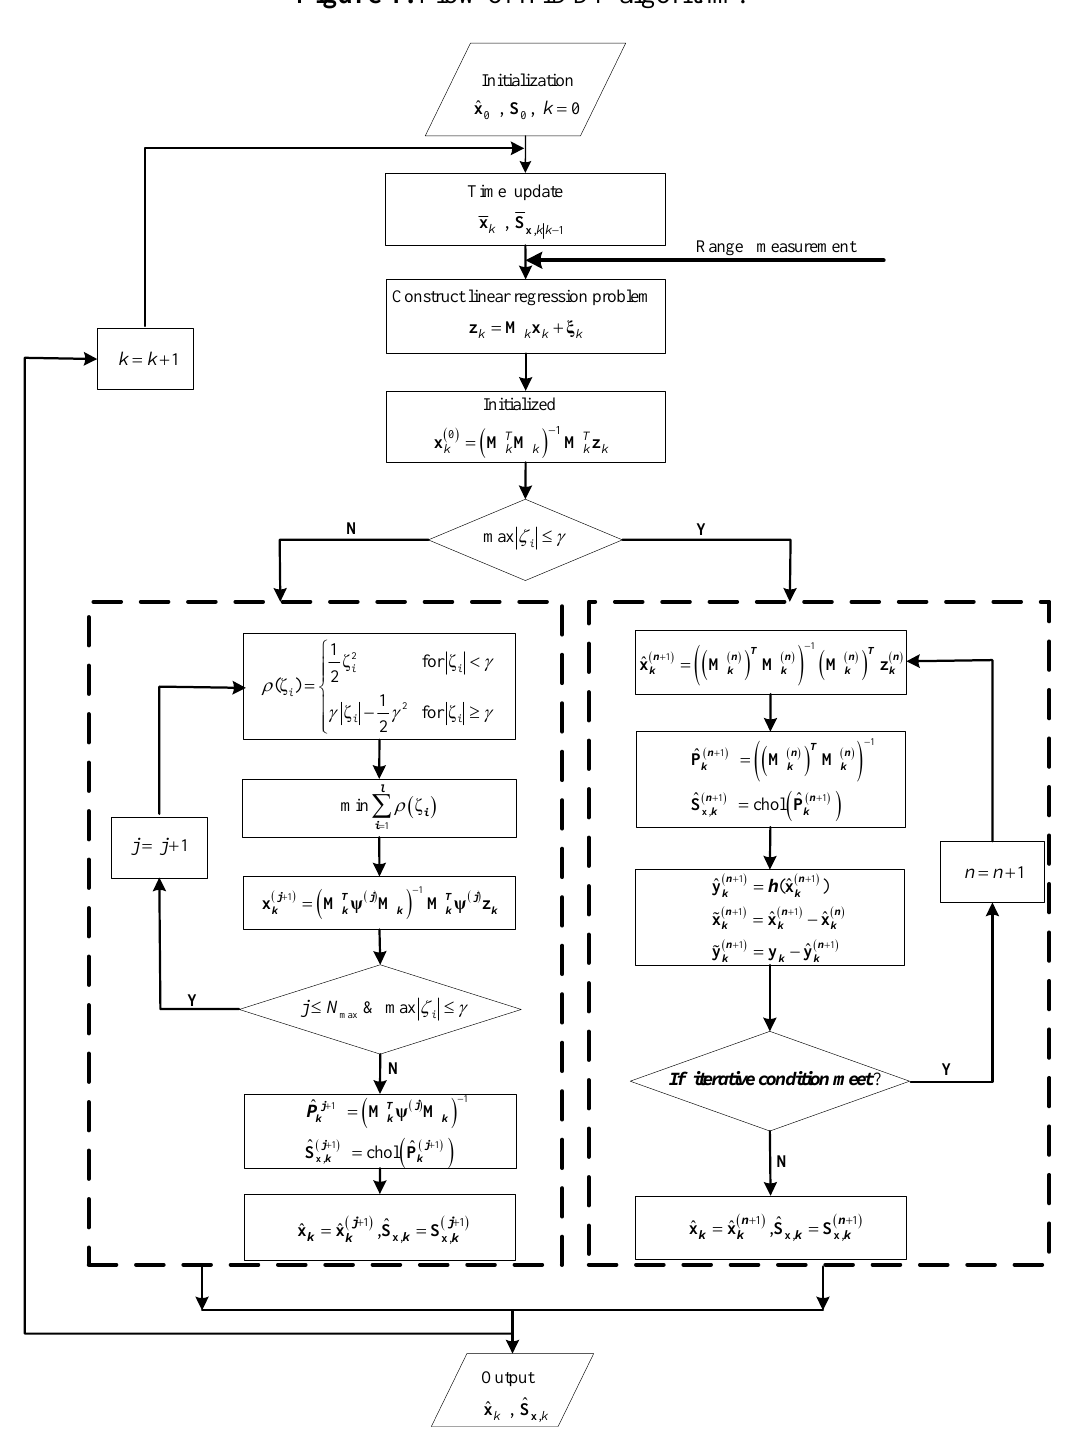
Figure 1. Flow of HIDDF